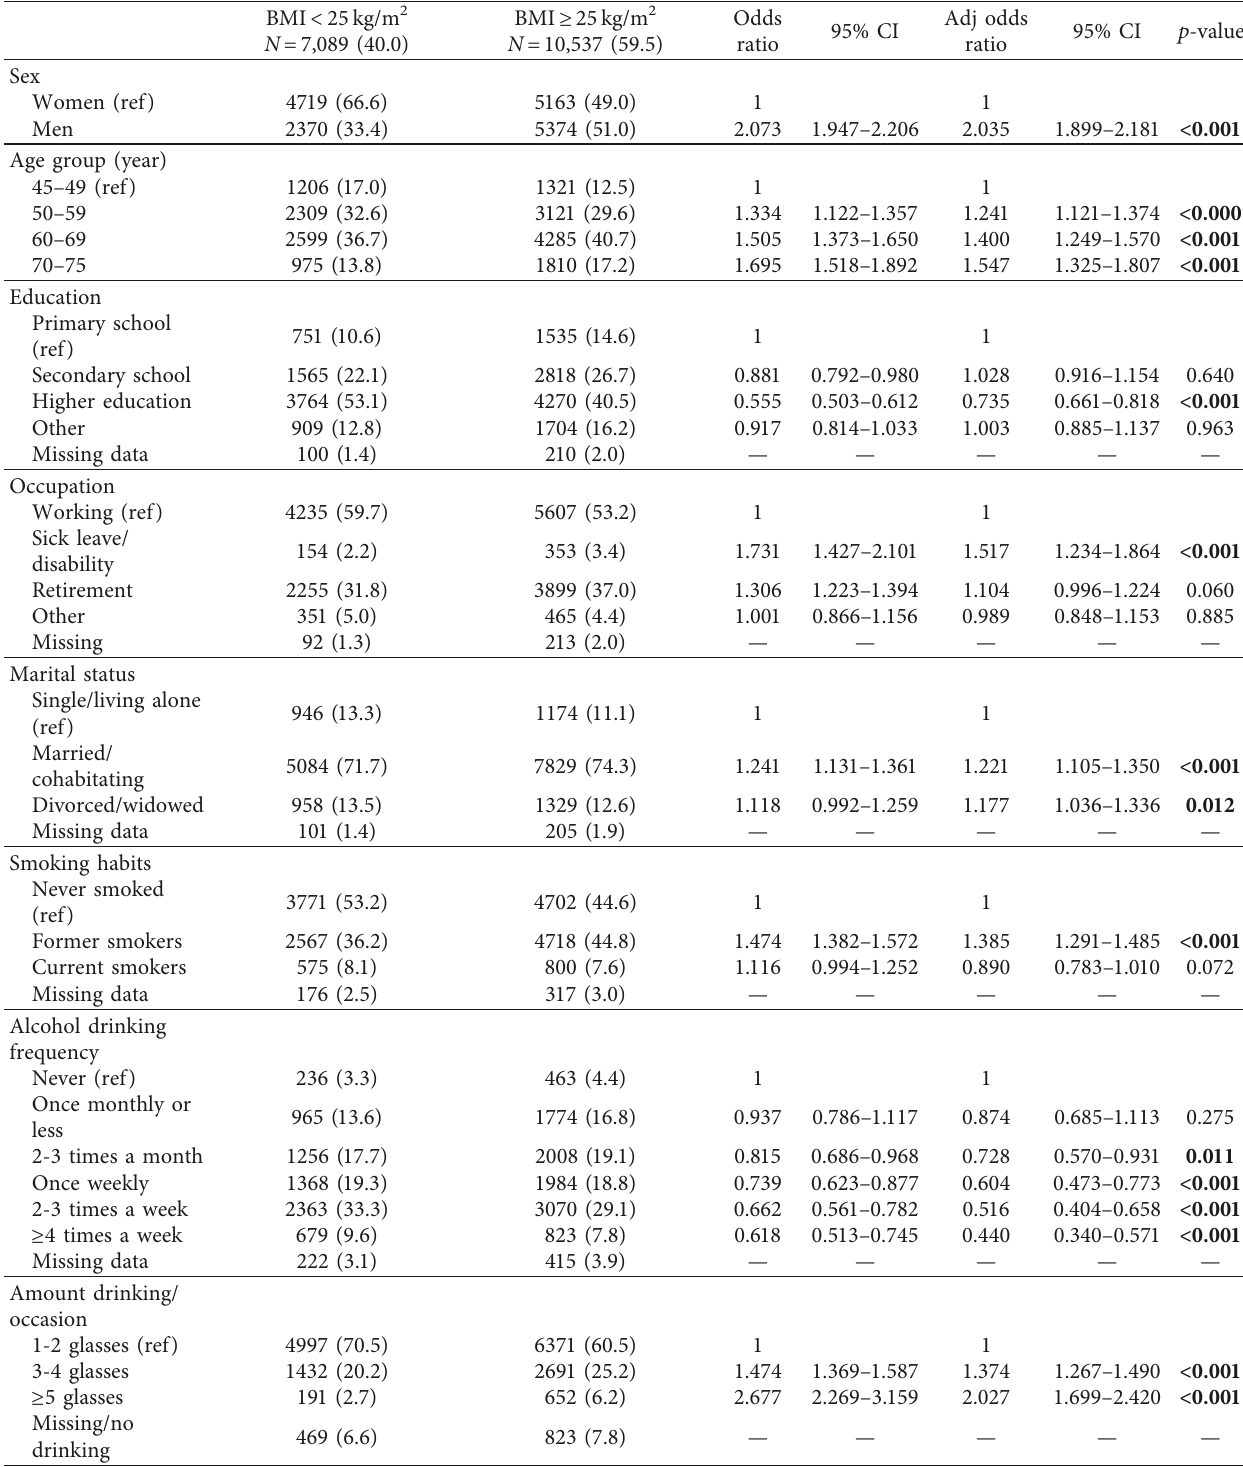
Table 1: Associations between BMI and sociodemographic factors and smoking and alcohol habits in the EpiHealth